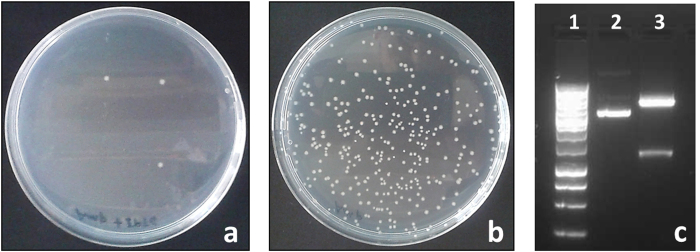
Effect of the positive selection marker on RapGene cloning.pRG1.0 was digested for two hours at 37 °C with AflII and NheI in the presence of T4 DNA polymerase and 1 mM dTTPs. After purification the prepared vector, with no insert, was transformed in E. coli NEB5α, SOC was added and cells were incubated for one hour at 37 °C, then one-fifth of the transformation was plated on LB supplemented with ampicillin plus IPTG (a) or ampicillin only (b). (c) Restriction profile of pRG1.0 used for this cloning. Lanes: 1, 1 kb ladder (Promega); 2, pRG1.0 undigested; 3, pRG1.0 digested with AflII, NheI and treated with T4 DNA polymerase in the presence of dTTPs.